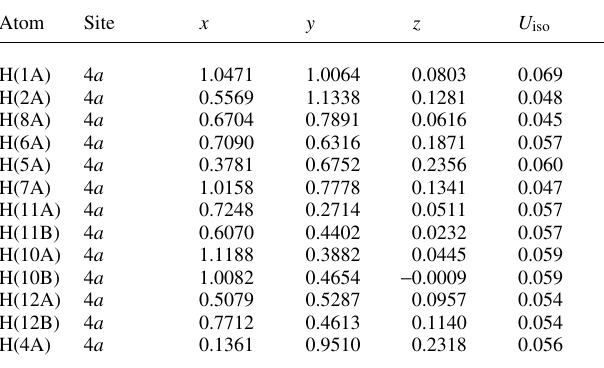
Table 2. Atomic coordinates and displacement parameters (in Å 2 )